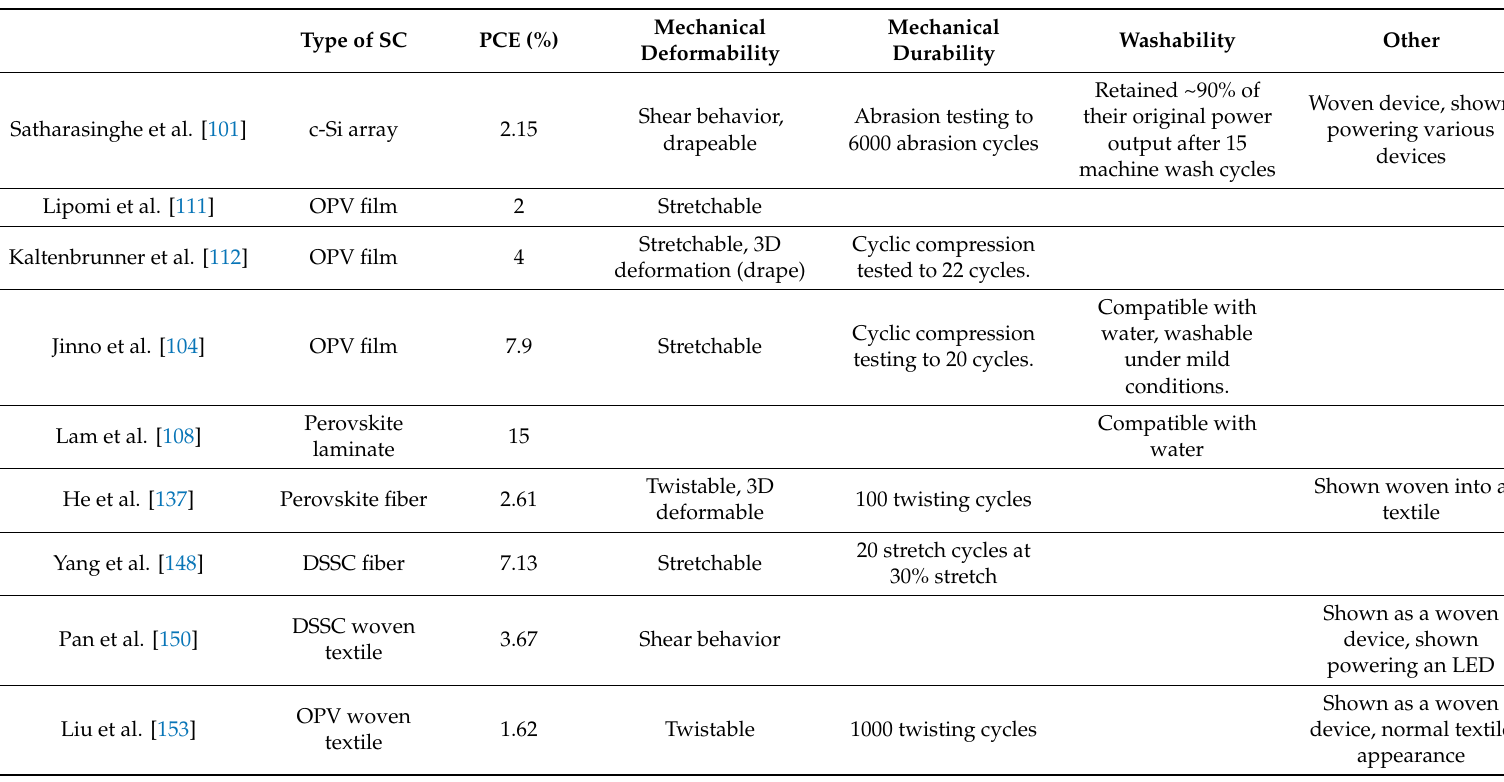
Table 4. Examples of solar E-textiles were textile properties other than flexibility and durability to repeated bending have been reported. Please note that PCE (%) are the values given and do not account for any di ff erences in how the PCE may have been calculated between